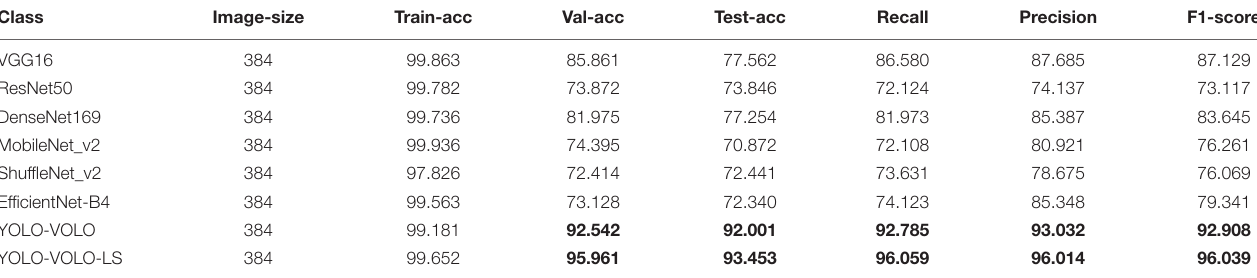
TABLE 7 | Comparison of modeling methods for lettuce variety recognition.